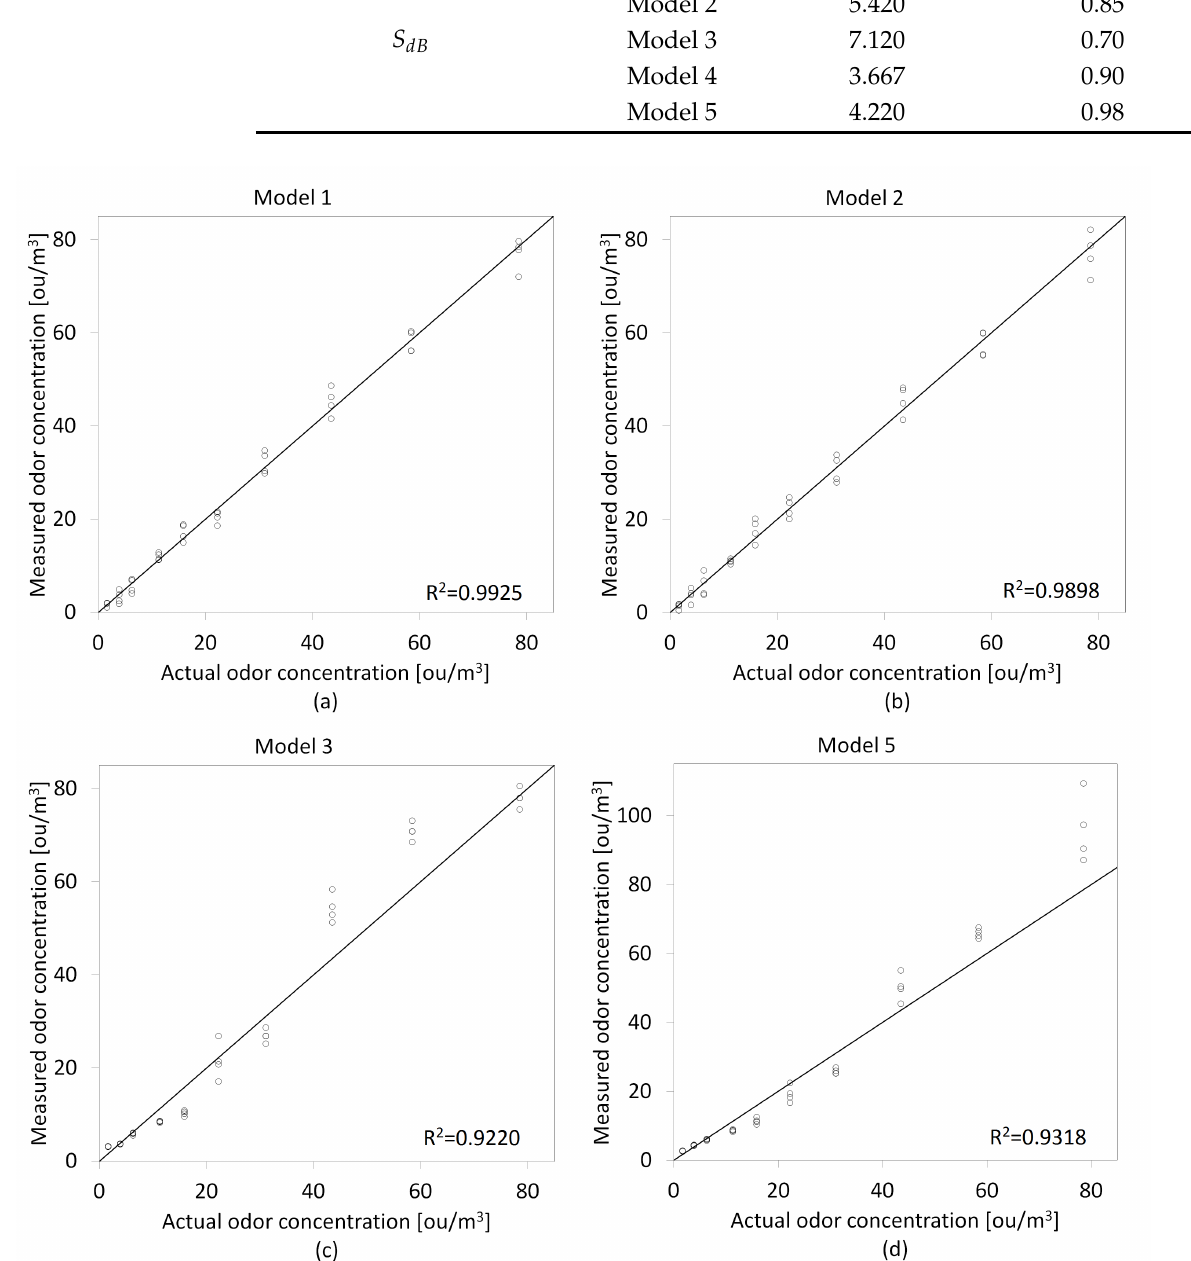
Figure 5. Comparison scatter plots of odor concentrations prediction models prepared using the maximum signal value— S max as an independent variable: ( a ) Model 1, ( b ) Model 2, ( c ) Model